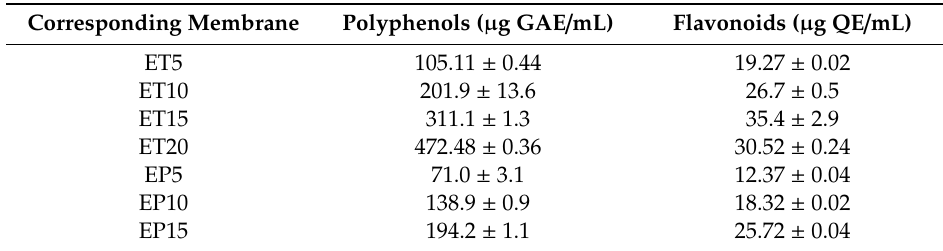
Table 4. Total concentration of polyphenols and flavonoids released from powder samples of tea or TGP in water or in EtOH-H 2 O (7:3 v/v ), respectively, after 24 h. The sample name refers to the membrane containing the same total amount of tea or TGP powder.